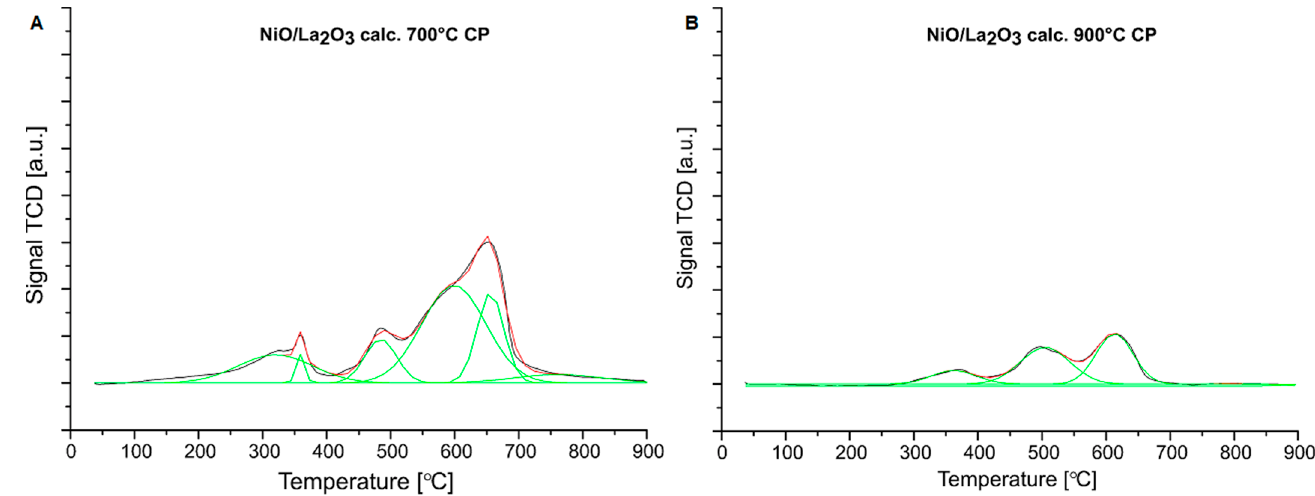
Figure 1. TPR-H 2 profiles of NiO/La 2 O 3 catalysts prepared by co-precipitation method and calcined at 700 °C ( A ) and 900 ( B ) °C in an air atmosphere for 4 h.